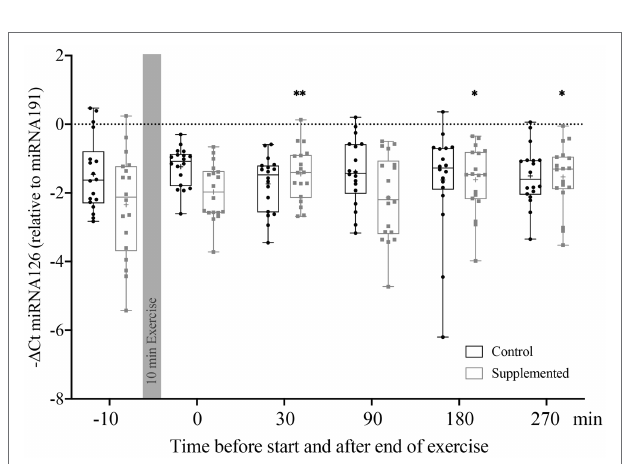
FIGURE 2 | Relative quantification of miRNA126 to miRNA191 in MNCs using the Δ Ct method ( n = 18). Bars include 50% of all data points while the line within the bars represents the median. Additionally, the mean is indicated by a “+”-sign in each bar. Whiskers represent minimum and maximum values with all individual data points being shown. Differences from baseline are indicated by *, with * p < 0.05; ** p <